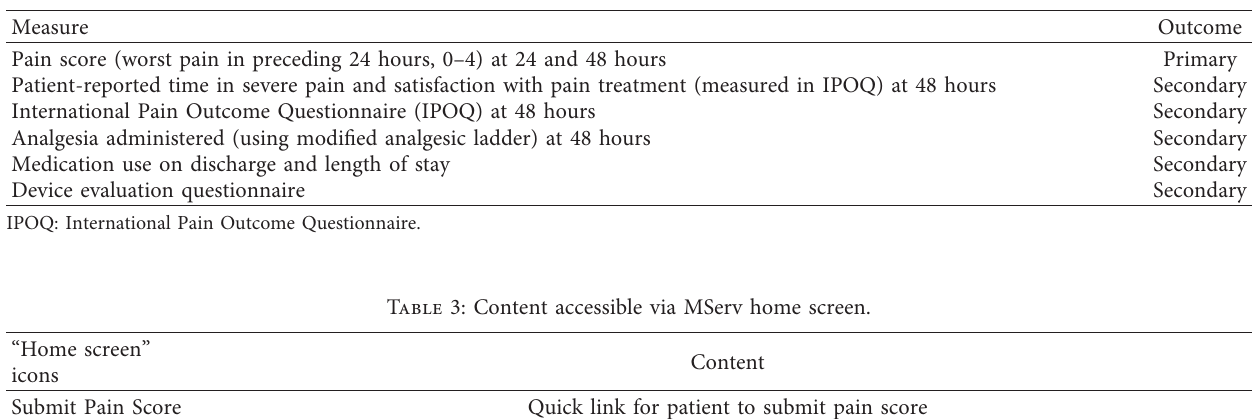
Table 2: Study measures summary